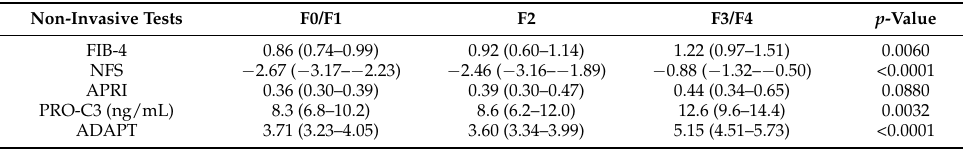
Table 2. Non-invasive tests according to the stages of hepatic fibrosis.